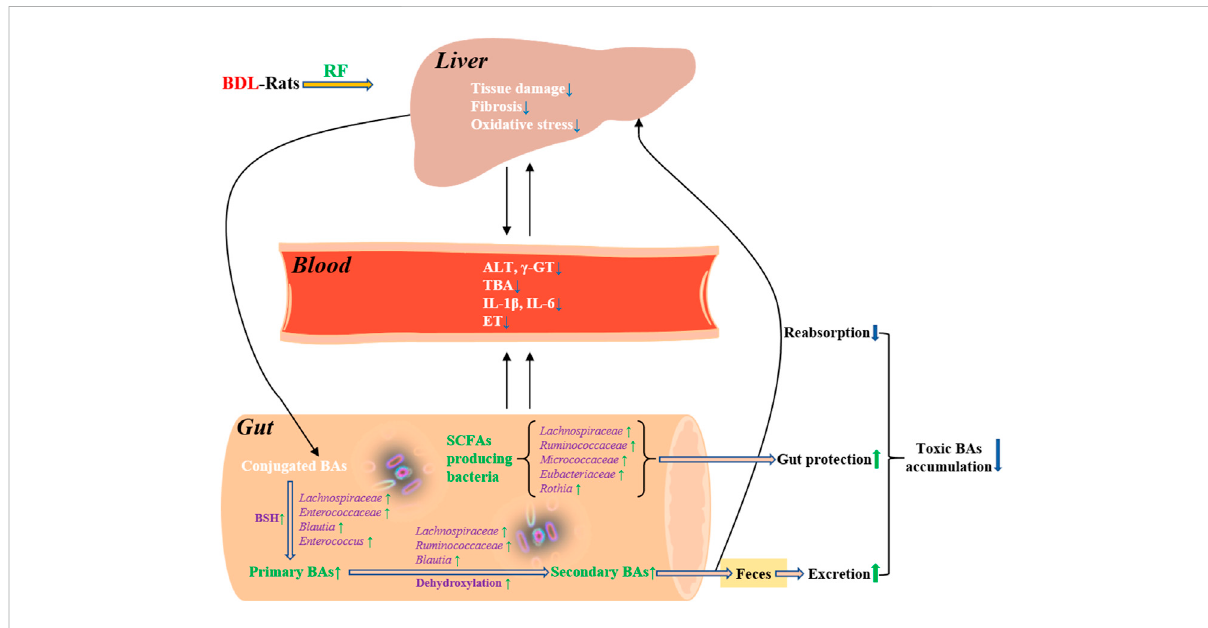
FIGURE 8 Detoxifying effects of RF on BDL-rats and the potential mechanisms involving bile acids metabolism and gut